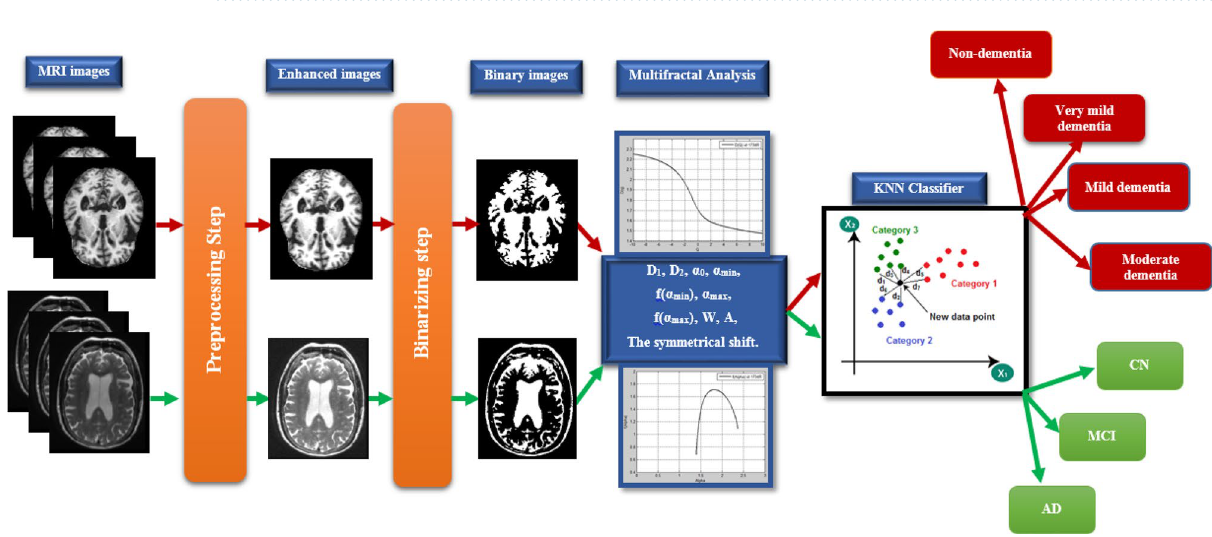
Figure 8. The workflow of the proposed